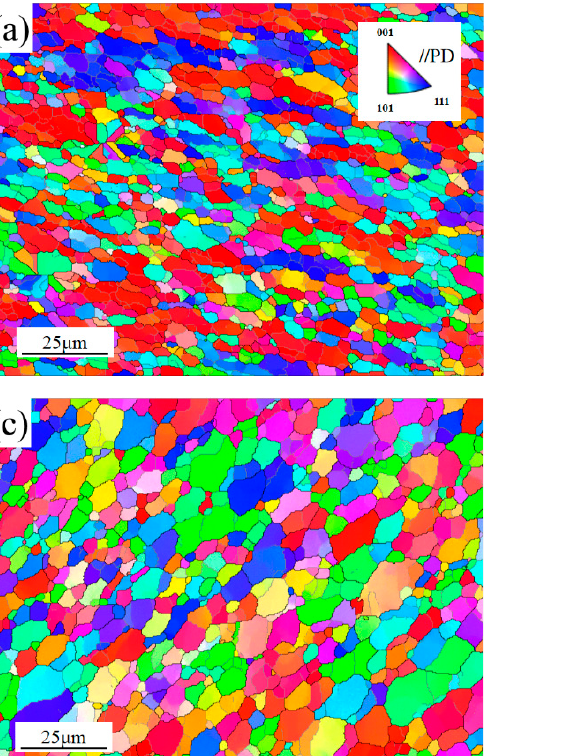
Figure 3. ( A ) Engineering strain curves of different processing parameters; ( B ) Engineering